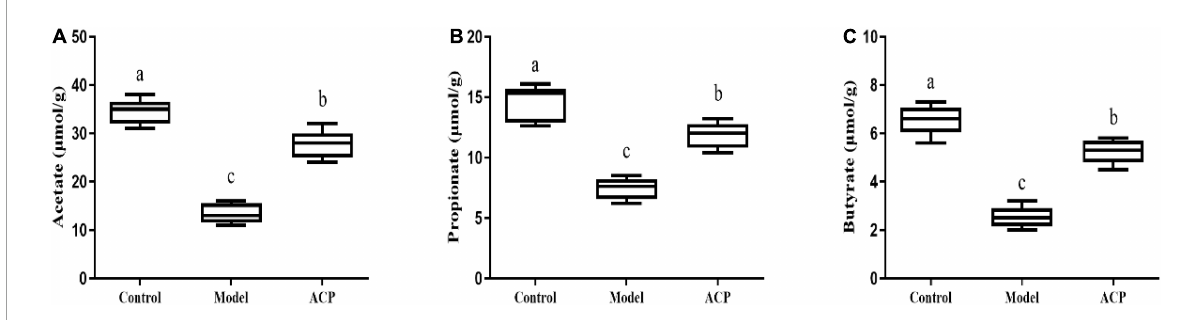
FIGURE7 Effect of Auricularia cornea var. Li. polysaccharides (ACP) supplementation on the short-chain fatty acids (SCFAs) in cecal contents in immunosuppressed mice. (A) Acetate; (B) propionate; and (C) butyrate. Values are mean ± SD ( n = 6 independent experiment). Different superscript letters indicate significant differences ( P < 0.05) by using one-way analysis of variance, followed by Duncan’s test.